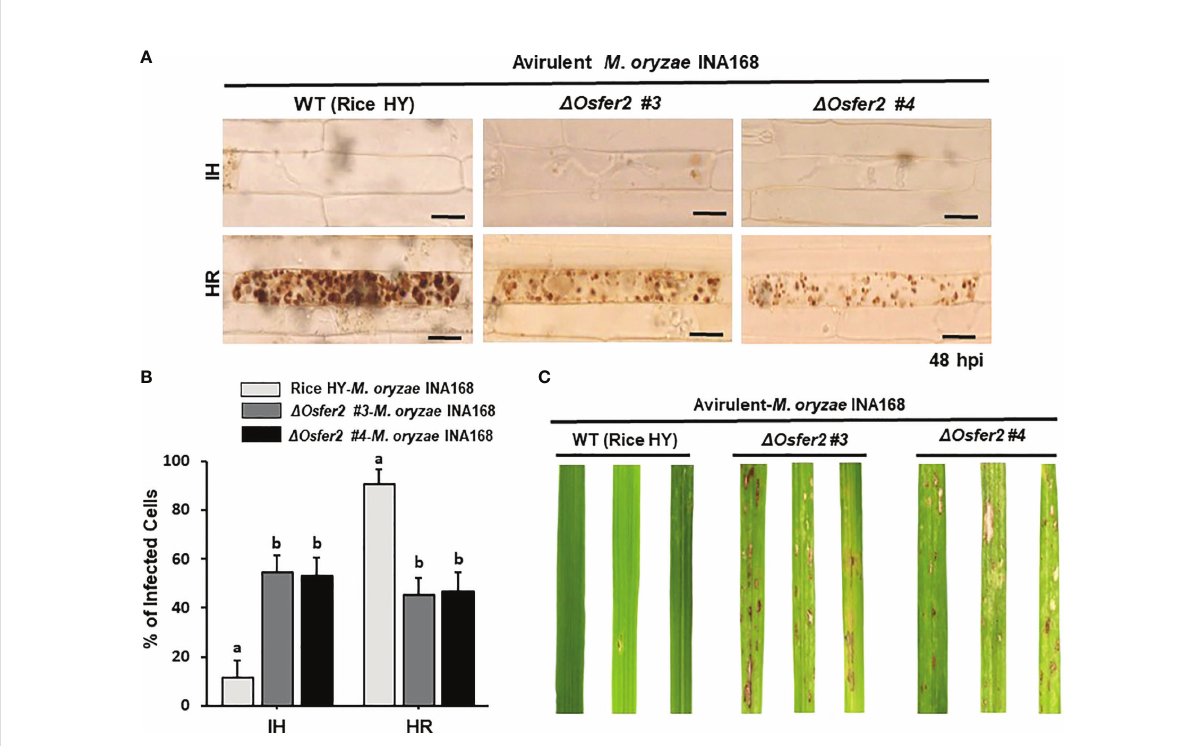
FIGURE 5 OsFER2 knock-out in the resistant cultivar HY suppresses resistant phenotypes in D Osfer2 knock-out mutants against avirulent Magnaporthe oryzae INA168 infection. Conidial suspension (4×10 5 conidia mL -1 ) of avirulent M. oryzae INA168 was inoculated onto the rice leaf sheaths in wild type (WT) rice HY and D Osfer2 knock-out mutant lines. (A) Microscopic images of rice sheath epidermal cells infected with M. oryzae. hpi, hours post-inoculation. Scale bar=20 m m. (B) Quanti fi cation of invasive hyphae (IH) and hypersensitive response cell death (HR) in rice sheath cells infected with M. oryzae (48 hpi). Numbers of IH and HR cells were counted in rice sheath cells infected with M. oryzae (48 hpi). The values are means ± SD (n=4 leaf sheaths from different plants). Different letters above the bars indicate signi fi cantly different means (P<0.05), as analyzed by one-way ANOVA analysis. (C) Disease phenotypes on rice leaves infected with M. oryzae INA168. Three-week-old rice plants were sprayed with a conidial suspension (4×10 5 conidia mL -1 ). Diseased leaves were photographed at 5 days after spray inoculation. hpi, hour post- inoculation; IH, invasive hyphae; HR, hypersensitive